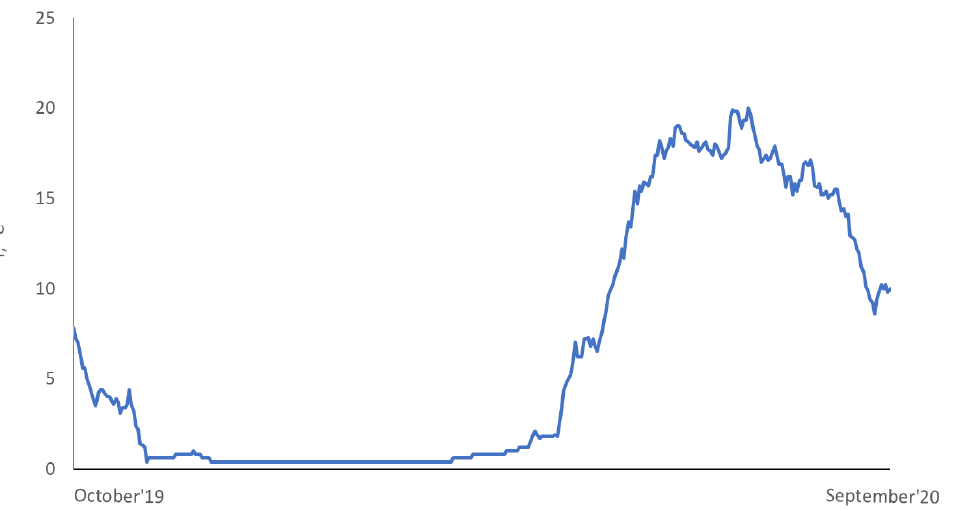
Figure 1. Water temperature from October 2019 to September 2020.